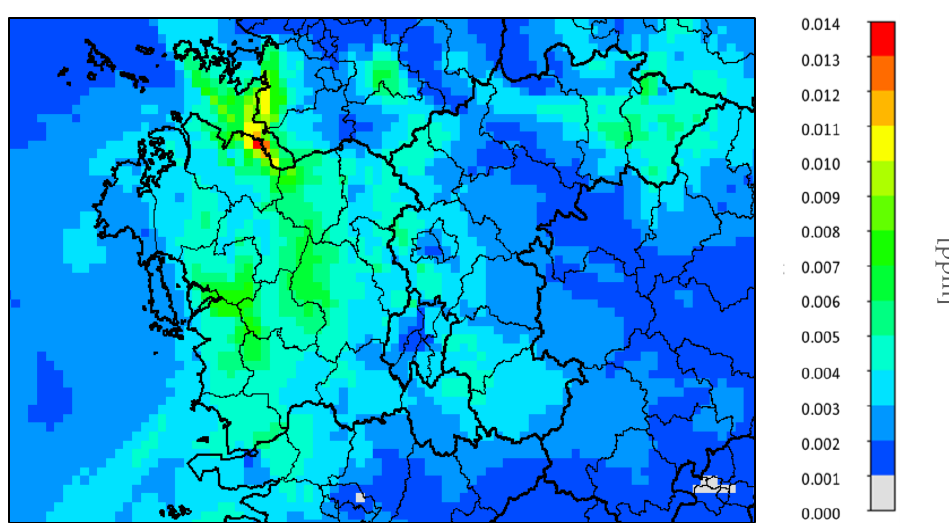
Figure 16. Monthly mean increases in maximum 8-h O 3 concentration under S2.